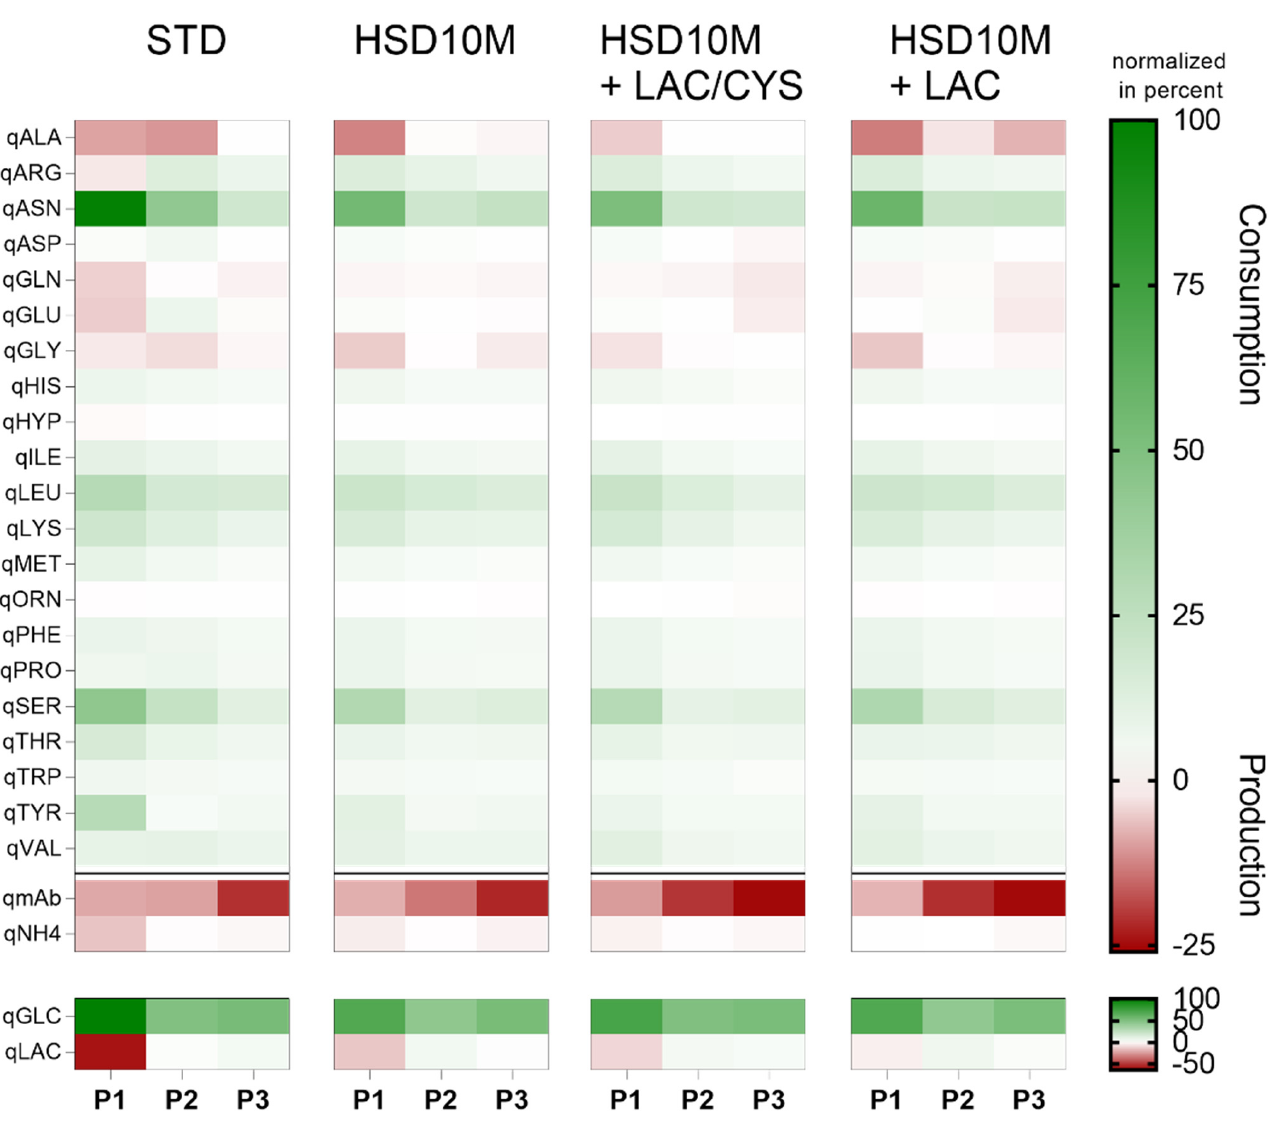
Figure 7. Heatmap of the median consumption and production of the amino acids, glucose, lac- tate and ammonium, and productivity. The phases of each process type were identified with segmented linear modeling for the processes: standard (2), HSD10M without supplementation (5), HSD10M with LAC supplementation (3) and HSD10M with LAC/CYS (2) supplementation. The number in the brackets shows the number of runs which were used for this analysis. STD, standard process with seeding density of 0.7 × 10 6 cells/mL; HSD10M, process with the seeding density 10 × 10 6 cells/mL; + LAC, supplemented with lactate; + LAC/CYS, supplemented with lactate and cysteine. ASP = aspartate; GLY = glycine; HIS = histidine; HYP = hydroxyproline; ILE = isoleucine; LYS = lysine; MET = methionine; ORN = ornithine; PHE = phenylalanine; PRO = proline; TRP = tryptophan; TYR = tyrosine; VAL = valine; mAb = monoclonal antibody. The prefix q describes the specific rates of consumption or release.